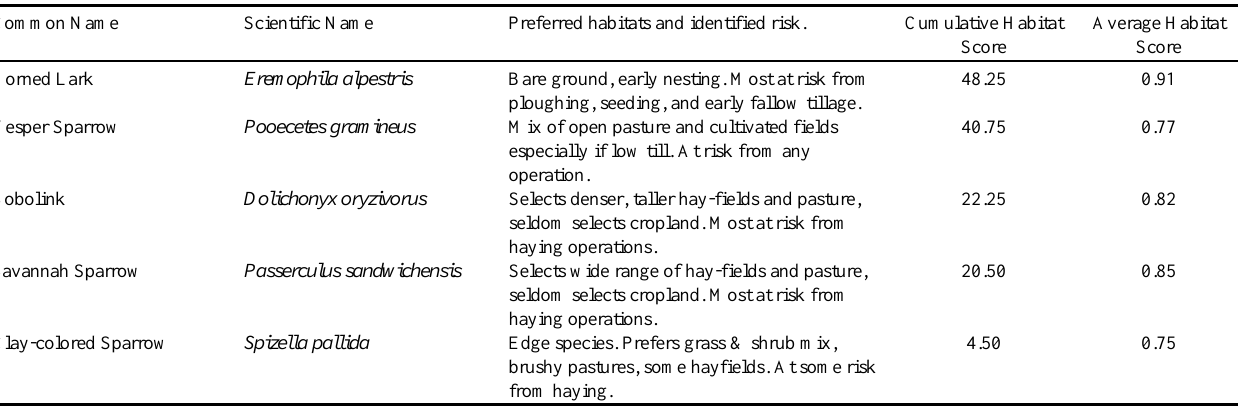
Table 1 . Migratory bird species and their agricultural habitat scores ranked by cumulative National Agri-Environmental Health Analysis and Reporting Program (NAHARP) habitat scores. For each species the score is calculated based on the NAHARP habitat matrix database where only categories 0.75 and 1.0 were retained. A high cumulative score identifies species highly associated with agricultural habitat types and that are widely distributed across all eco-regions in Canada. A high average score identifies species highly associated with agricultural habitat types independent of regional